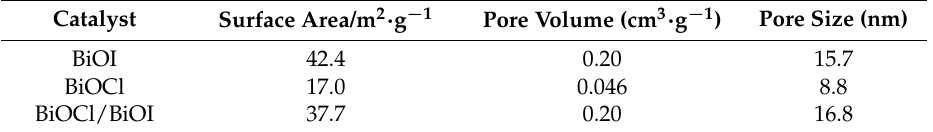
Figure 7. Adsorbed MO in the dark for BiOX (X = Cl, Br, I) and BiOI/BiOX (X = Br, Cl) composites ( C 0 = 20 ppm, catalyst dosage = 0.2 g/L).